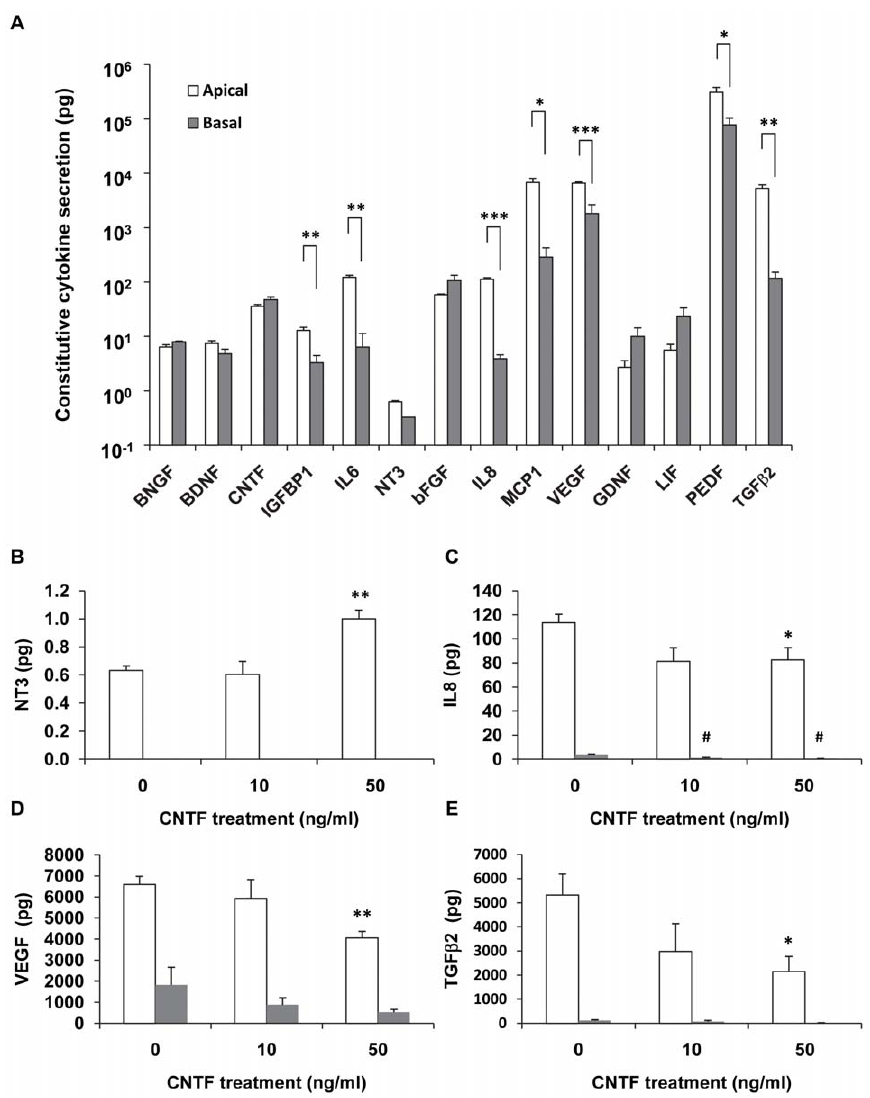
Figure 10. Effect of CNTF on polarized cytokine secretion from hfRPE. A. Constitutive secretion of cytokine and neurotrophic factors from confluent monolayer of hfRPE. * P , 0.05, ** P , 0.01, *** P , 0.001 comparison between apical and basal compartment; B–C. CNTF-induced secretion changes of NT3, IL8, VEGF, and TGF b 2. * P , 0.05, ** P , 0.01, compared to the apical compartment of untreated control; # , 0.05, compared to the basal compartment of untreated